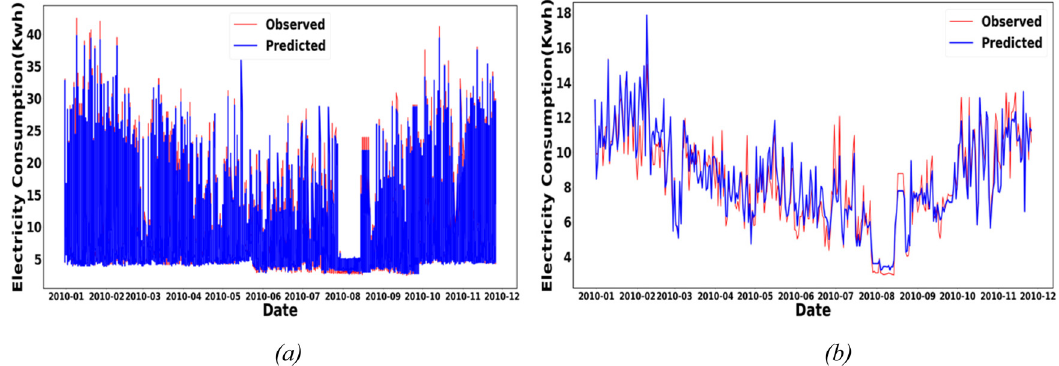
Figure 9: Household prediction vs original observations resampled to: ( a ) hourly granularity, and ( b ) daily